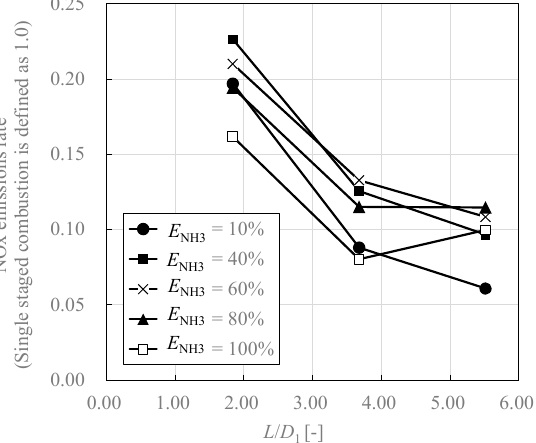
Figure 9. Comparison of NOx emissions rates for different L / D 1 . Input = 11.63 kW, λ total = 1.2, D 2 / D 1 = 0.24.